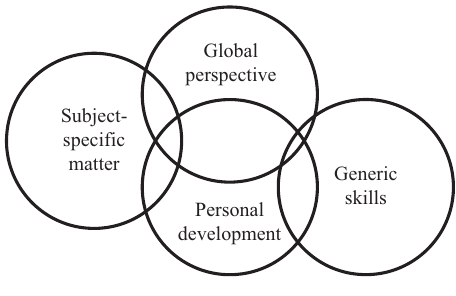
Figure 1. Impact structure